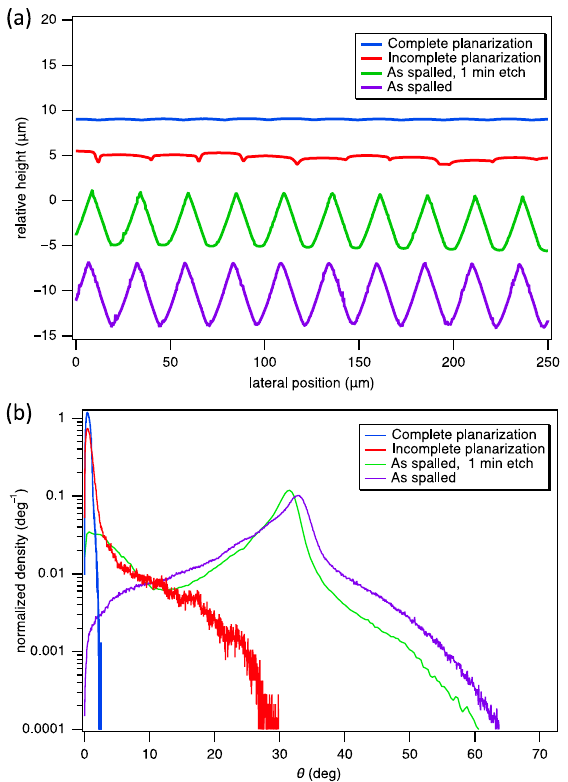
Figure 3. ( a ) Line profiles for as-spalled and as-grown solar cell surfaces. Profiles are separated by arbitrary height for viewing clarity. ( b ) Distribution of angles of the surface normal to the [100].